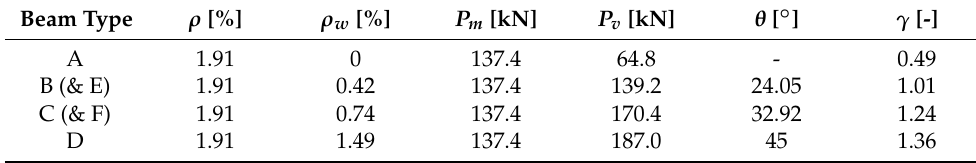
Figure 2. Schematic of the RC beams tested (all dimensions in mm). Table 4. Reinforcement amount and capacities determined for each beam